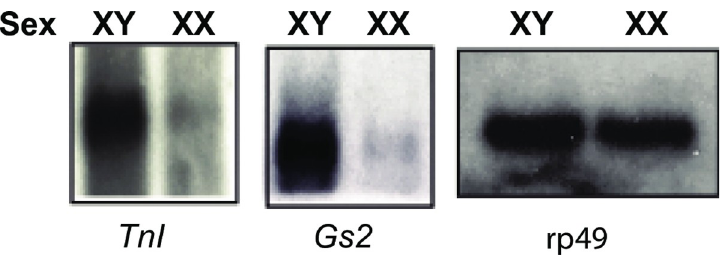
Fig 6. Sex-specific expression of genes containing SXL-binding sites, which are identified by the genomic SELEX. Northern analysis of the poly(A)+ RNA isolated from w 1118 adult male (XY) or female (XX) flies. Radiolabeled probes corresponding to selected sequences ( Gs2 and TnI ) or the ribosomal protein 49 ( rp49) gene sequence (used as a loading control) were used to probe the RNA blots.